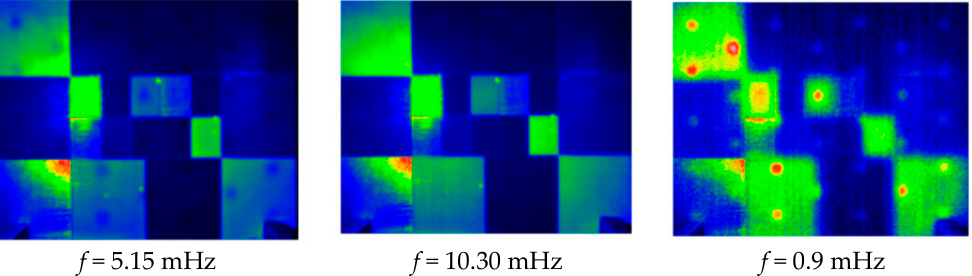
Figure 15. Module images of the calculated harmonic response.